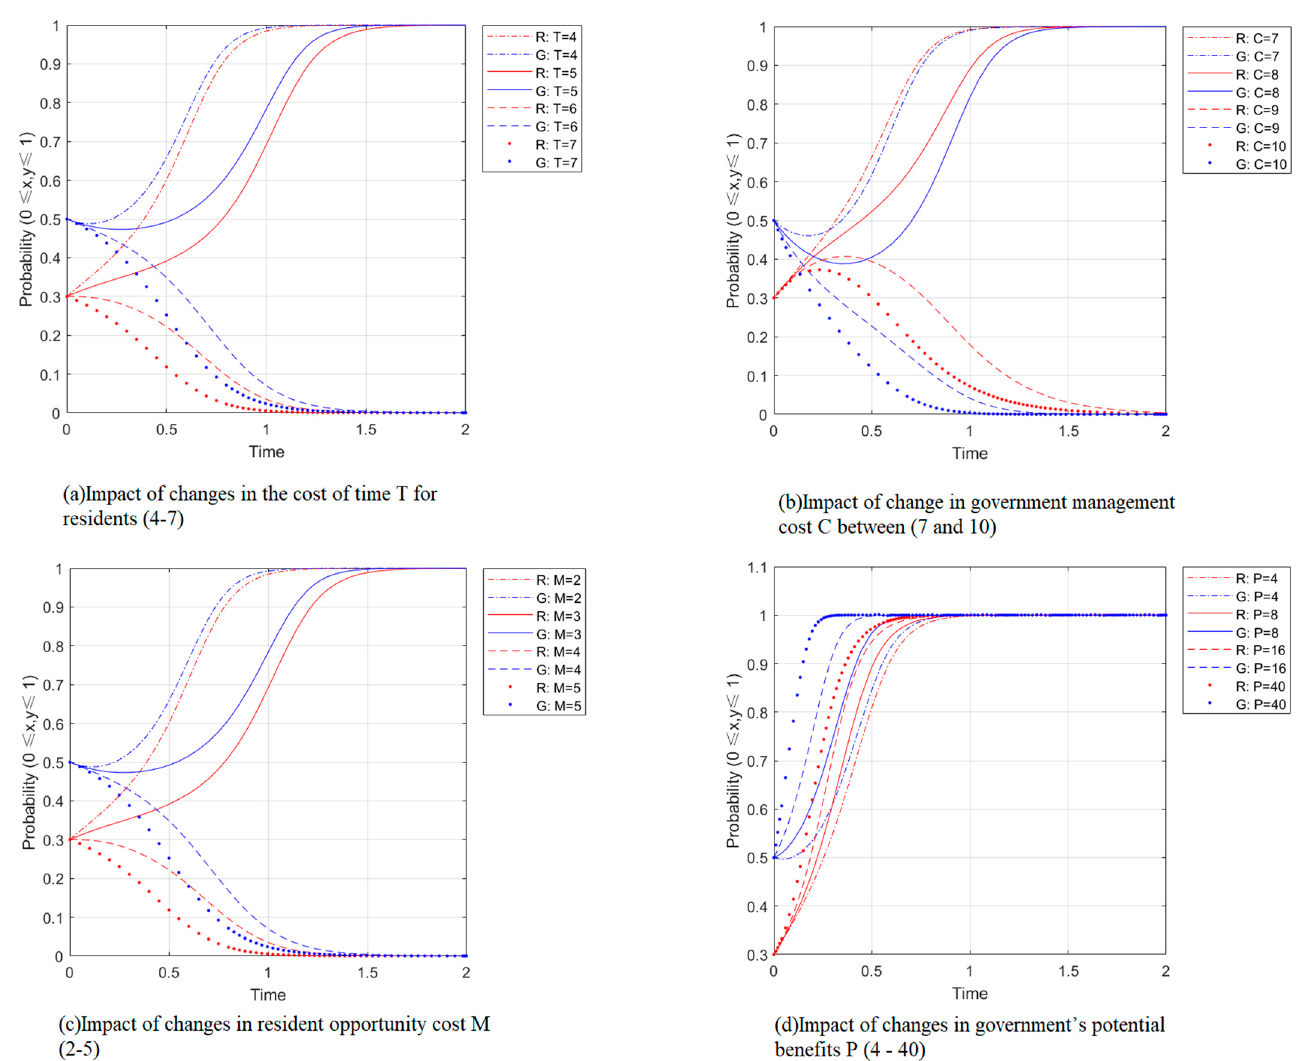
Figure 4. Impact of changes in time costs, management costs, opportunity costs, and potential benefits.